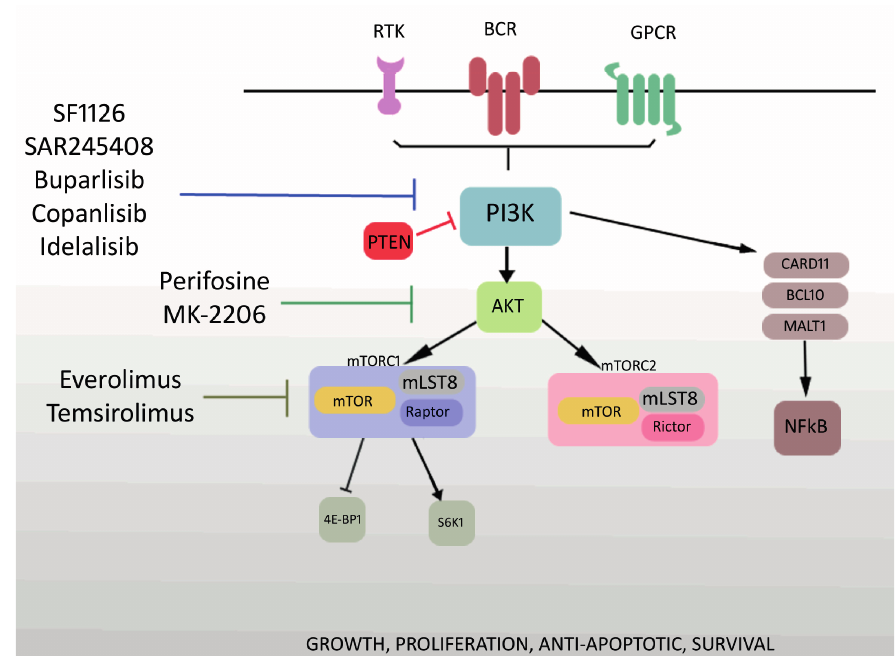
Figure 1. Schematic representation of the PI3K signaling pathway and sides of action PI3K/Akt/mTOR pathway inhibitors.